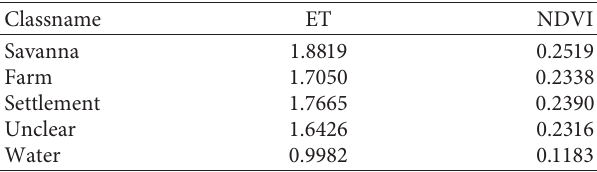
Figure 2: Evapotranspiration and normalized difference vegetation index map for 28/02/2015. Table 1: ET and NDVI values in February. Table 2: ET and NDVI values in